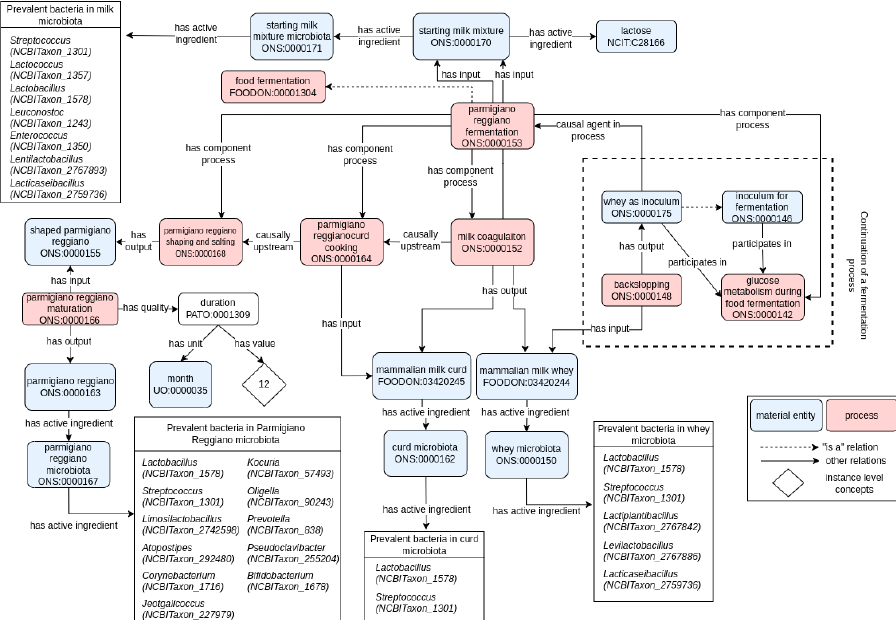
Figure 4. Ontological model of Parmigiano Reggiano fermentation. Solid arrows represent semantic relations in RO (annotated with their label), while dashed arrows represent hierarchical relationships (i.e., “is a” relation). Pink and blue rectangles refer to process or material entity, respectively. The label and the term ID (formatted as an ontology prefix followed by a number) are reported for each class. Classes are generally conceptualized to the universal level (i.e., the definition and concepts apply to any possible class instance). When suitable, instance-level concepts (indicated with white rhombus) are used to indicate a particular instance of the universal concept. For example, the prevalent bacteria genera in Parmigiano Reggiano microbiota are specific instances of the universal “bacteria” (or suitable taxonomical subclassifications) concept (i.e., only some specific instances of the Lactobacillus genus are the active ingredient of the Parmigiano Reggiano microbiota, but not the entirety of the Lactobacillus concept).